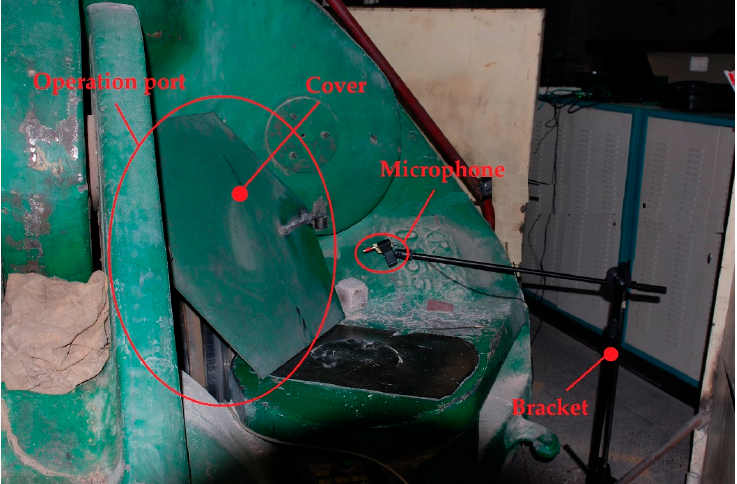
Figure 5. The location of the measuring microphone.